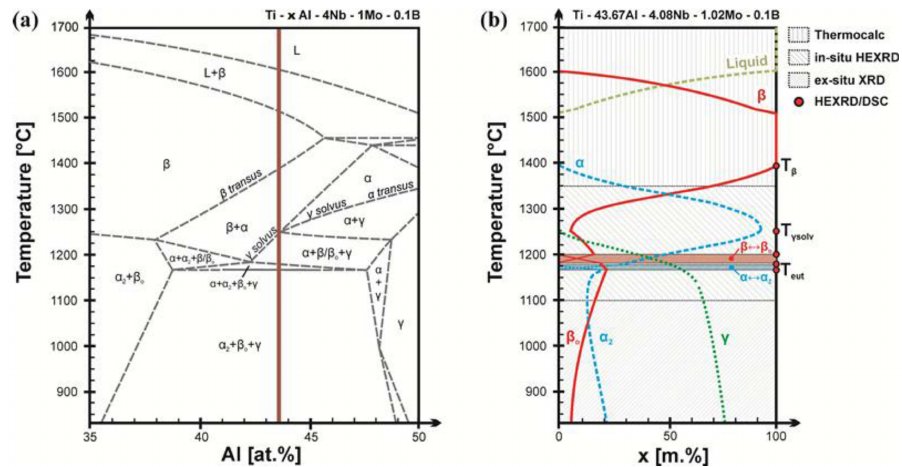
Figure 5. Quasi-binary section through the TNM alloying system ( a ) and experimentally-determined evolution of phase fractions of a Ti–43.67Al–4.08Nb–1.02Mo–0.1B (at. %) alloy ( b ). (Reprinted from Reference [37], Copyright (2014), with permission from